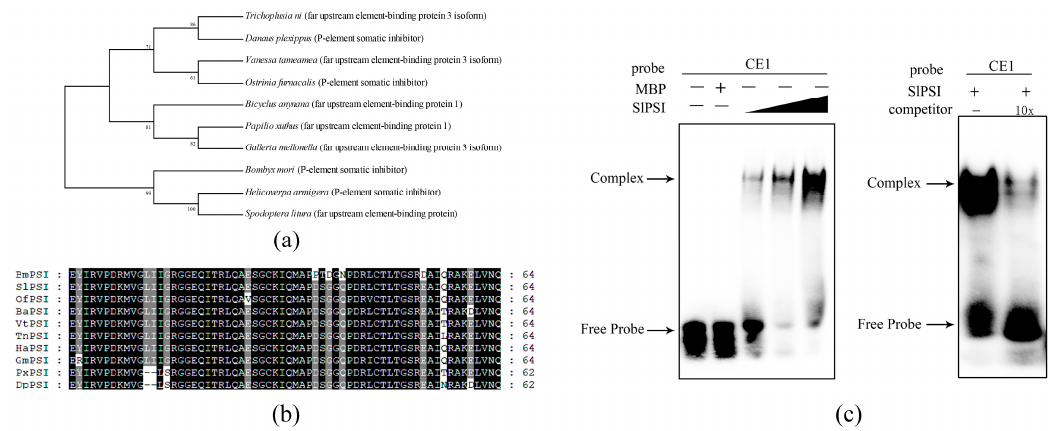
Figure 4. The combination of PSI and CE1 is conserved in Spodoptera litura : ( a ) A phylogenic tree based on the PSI of 10 species. ( b ) Conservation analysis of KH_1 motifs in these 10 species. The black color represents that amino acids are completely identical. The gray color represents that partial amino acids are identical. ( c ) SlPSI concentration gradient EMSA and cold competition EMSA.